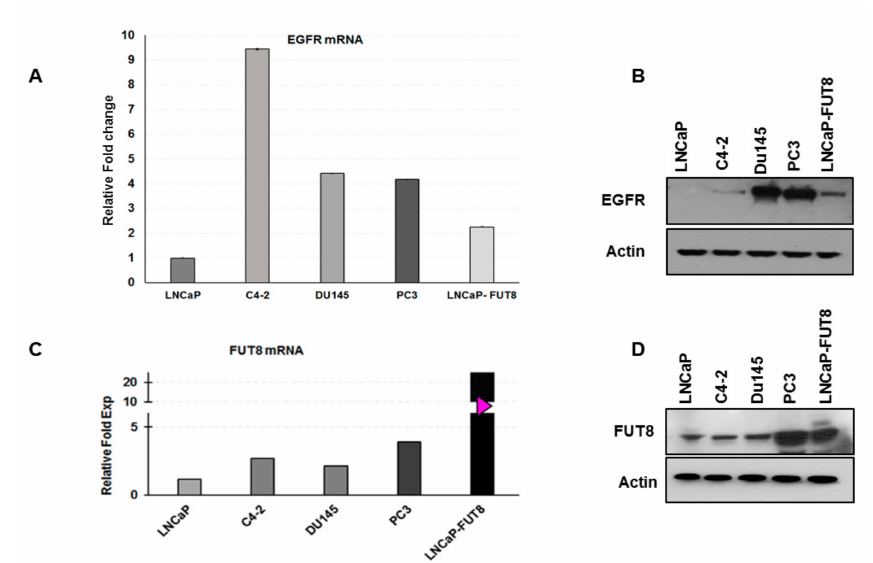
Figure 5. FUT8 regulates EGFR expression. The qRT-PCR and Western blot analysis of di ff erent prostate cancer cell lines showing the expression of EGFR ( A , B ) and FUT8 ( C , D ). Error bars represent ± SE of the mean. Significance was defined as the p -value ≤ 0.05 ( A , C)